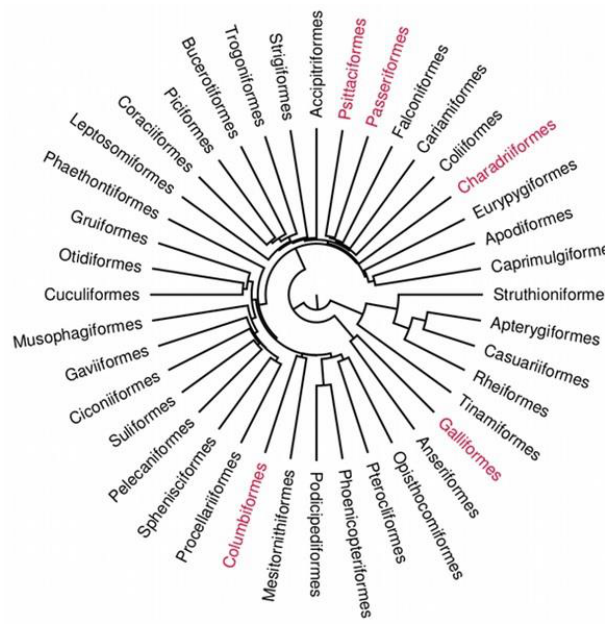
Figure 1. Visualization of alcohol consumption on an avian phylogenetic tree. Orders identified drinking alcohol are marked in red.